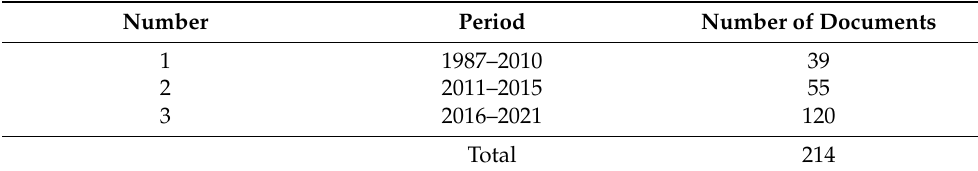
Table 1. Number of documents per